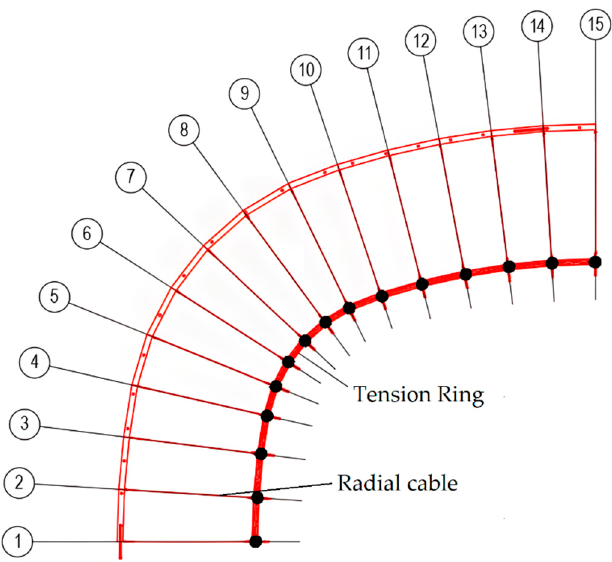
Figure 53. Radial cables. (1~15 represent the radial cables’ NO. corresponding to the axis.)